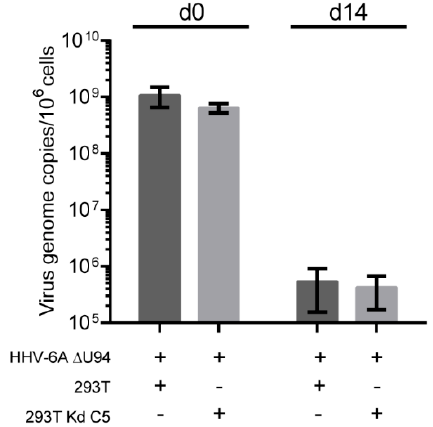
Figure 4. The effect of HHV-6A U41/U70 knockdown on telomere integration in a clonal knockdown cell line. The integration assay was performed as described in Figure 3A but using the U41/U70 single cell clone (Kd C5). Mean virus DNA copies per million cells was quantified by qPCR against viral U86 and cellular B2M. This number is shown in the histogram ( n = 3 ± SEM).